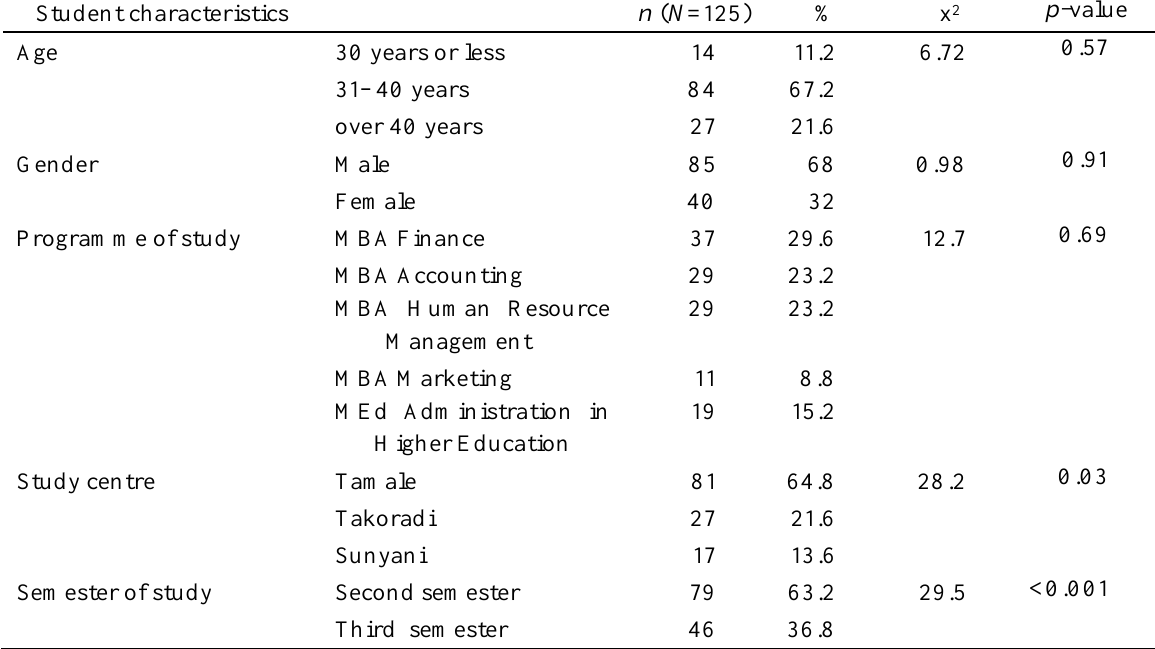
Association Between Respondent’s Characteristics and Satisfaction Student